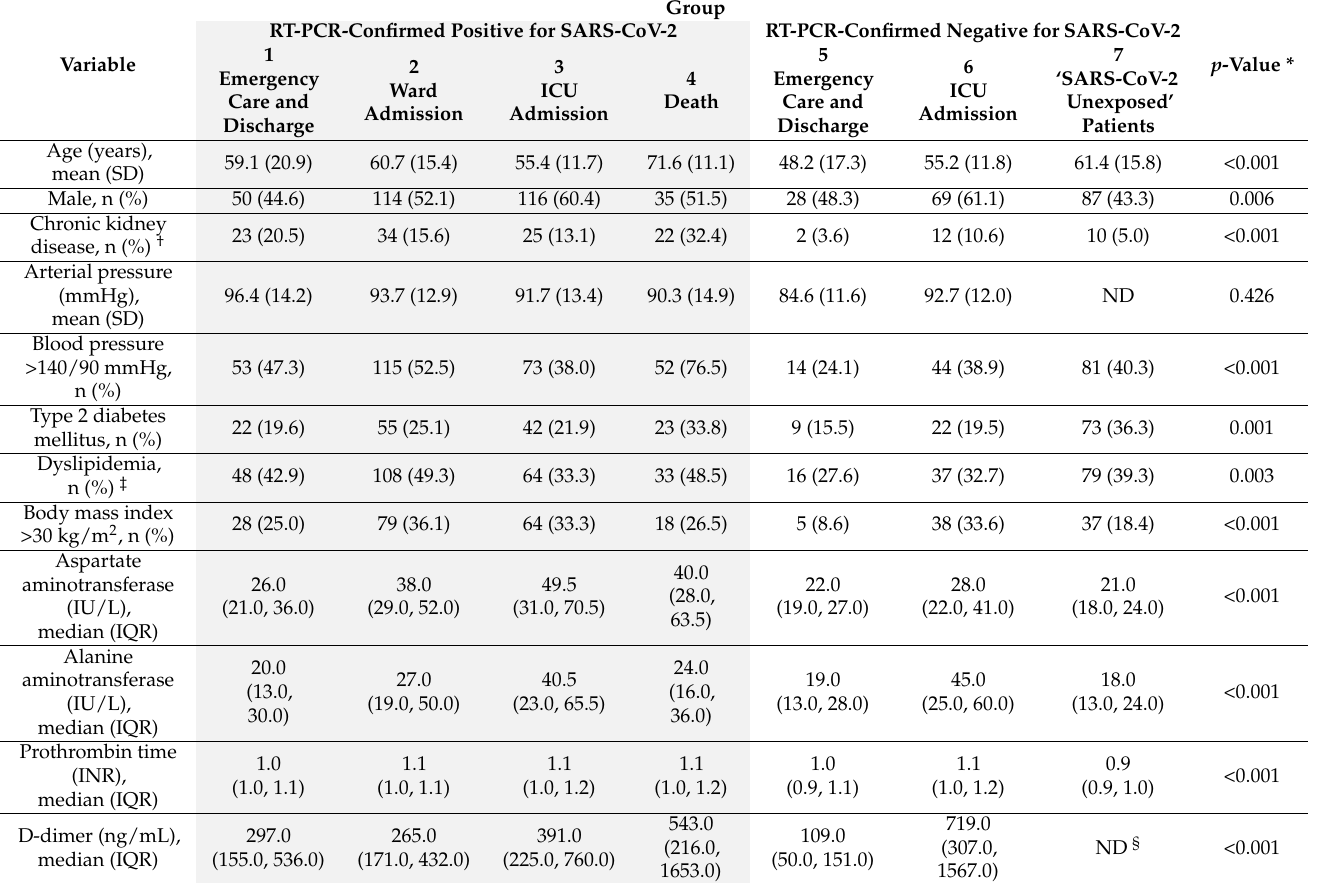
Table 2. Selected demographic, clinical, and biochemical characteristics of the patient